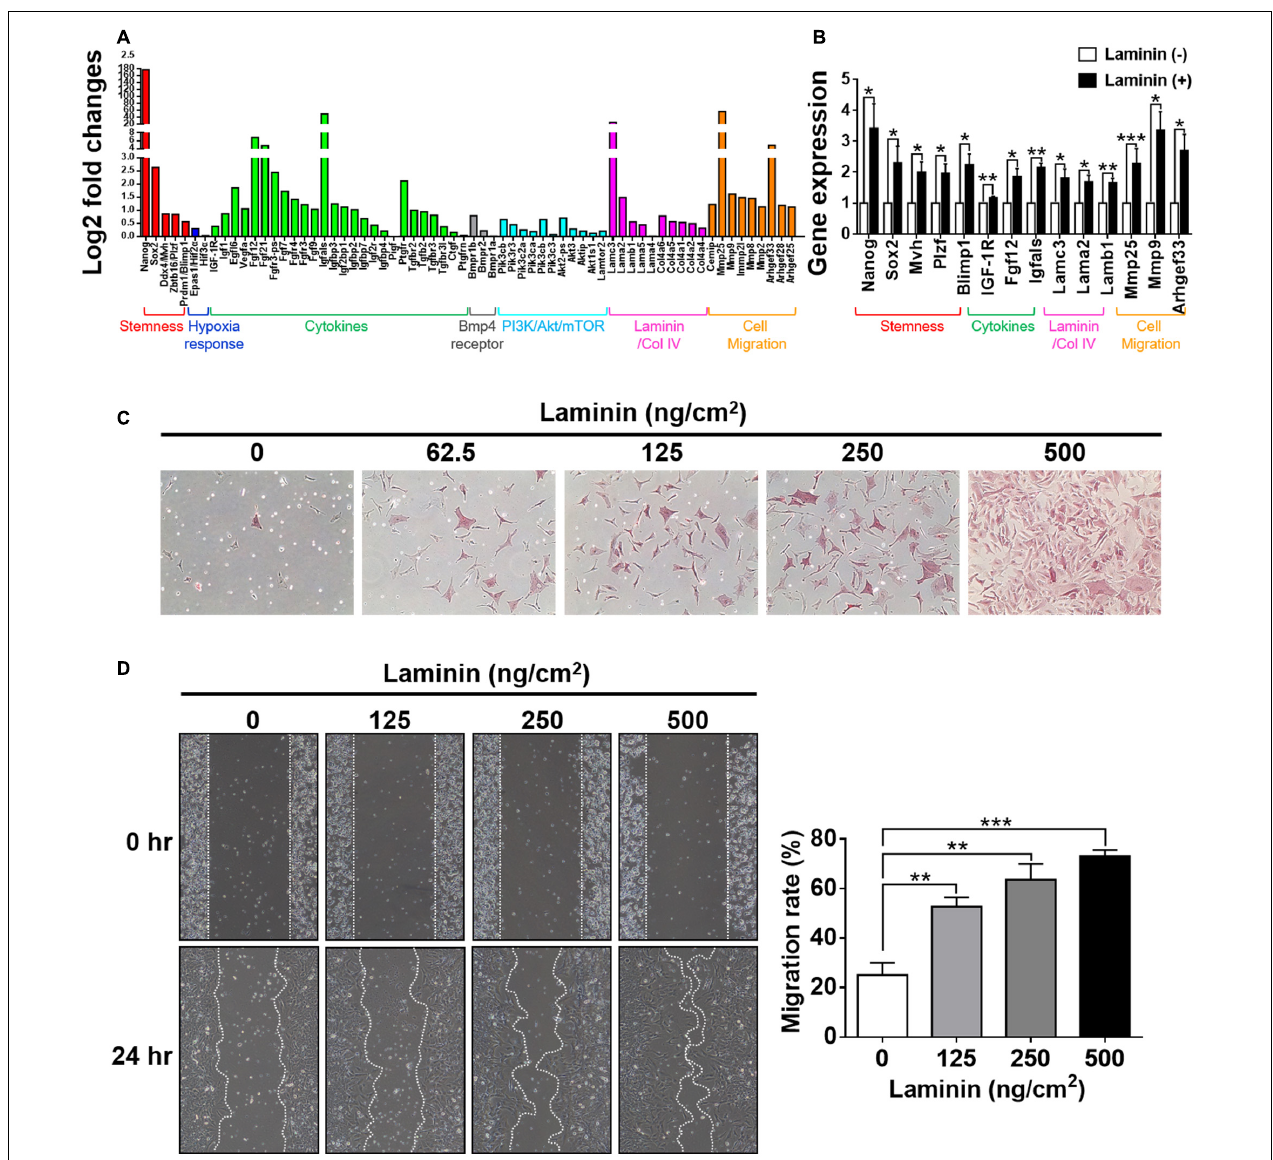
FIGURE 5 | Laminin induces morphological changes and genetic reprogramming. (A) Analyses of RNA-seq data collected from CD49f + AP + GSCs cultivated on laminin-coated and non-coated substrates. Genes were grouped into color categories. Red: stemness. Blue: hypoxia responses. Green: cytokines. Black: BMP4 receptors. Cyan: PI3K/Akt/mTOR pathway. Pink: basement membrane components. Orange: cell migration. (B) Validation of RNA-seq data in (A) by RT-qPCR. Data are means ± SEM of at least three independent experiments. * p < 0.05; ** p < 0.01; *** p < 0.001 (Student’s t -test). (C) Dose-dependent effects of laminin on cell morphology and alkaline phosphatase (AP) activity. The intensity of the red stain indicates AP activity. (D) Wound-healing assay showed that laminin coating enhanced cell migration in a dose-dependent manner. Data are means ± SEM of at least three independent experiments. ** p < 0.01; *** p < 0.001 (one-way